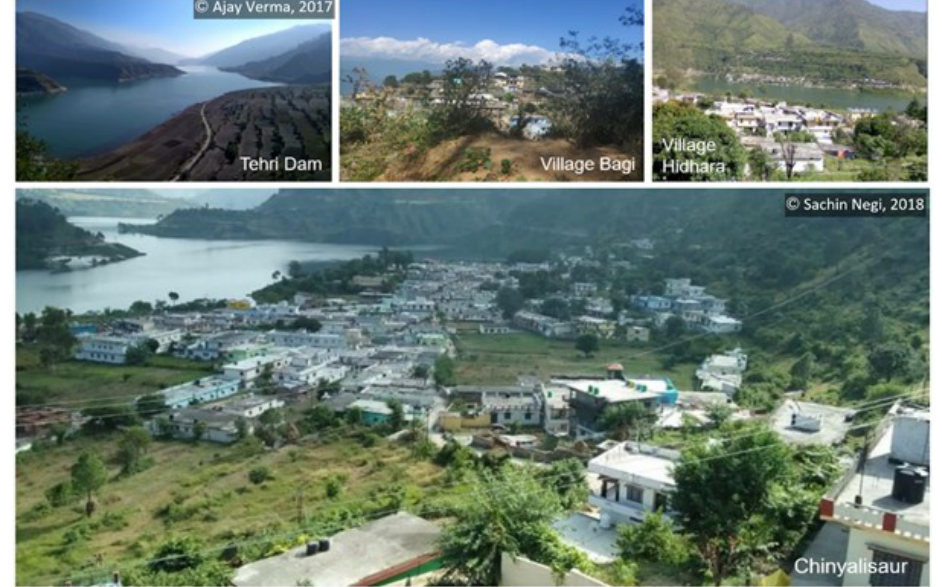
Figure 5. View of the site selected for the pilot